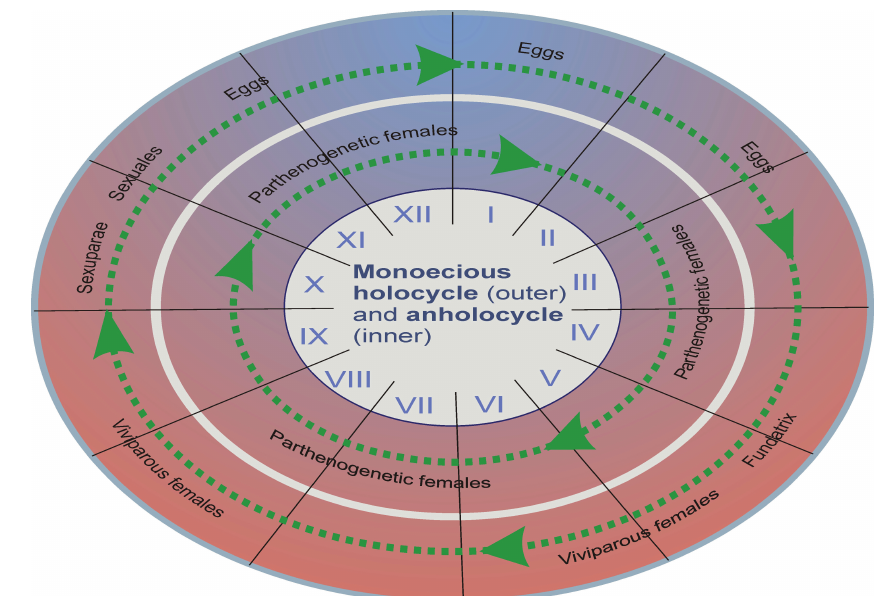
Fig. 2. Monoecious one-year life cycles. In the outer zone an ordinary monoecious holocycle in Aphididae. The fertilized egg overwinters and in spring the first viviparous parhenogenetic generation, the fundatrix (stem-mother) hatches. Upon the fundatrix follows a variable number of viviparous females (viviparae), apterous and/or alate. In autumn (sometimes earlier) sexuparae are born and in turn give birth to oviparous (sexual) females (ovipara) and males, which mate, and the oviparae lay eggs. the inner zone shows an anholocycle, with only parthenogenetic females (viviparous in Aphididae, oviparous in Adelgidae).